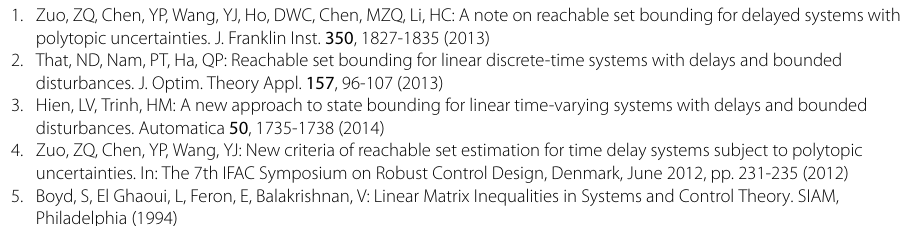
and time delay . ≤ τ ( t ) ≤ ., μ = .. The reachable set of system () is plotted in (cid:27) (cid:26) . –. Figure  with P = –. .